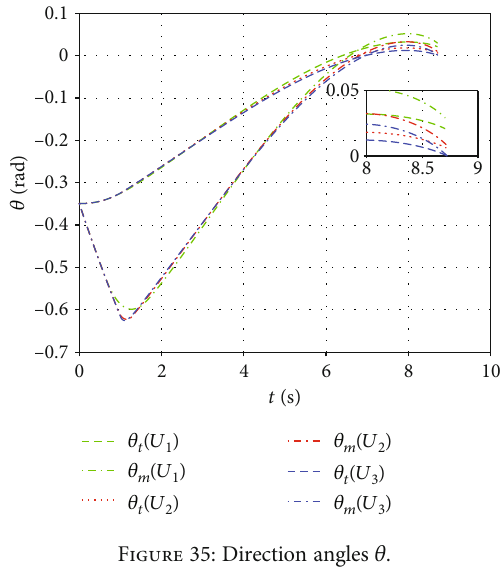
Figure 35: Direction angles θ .